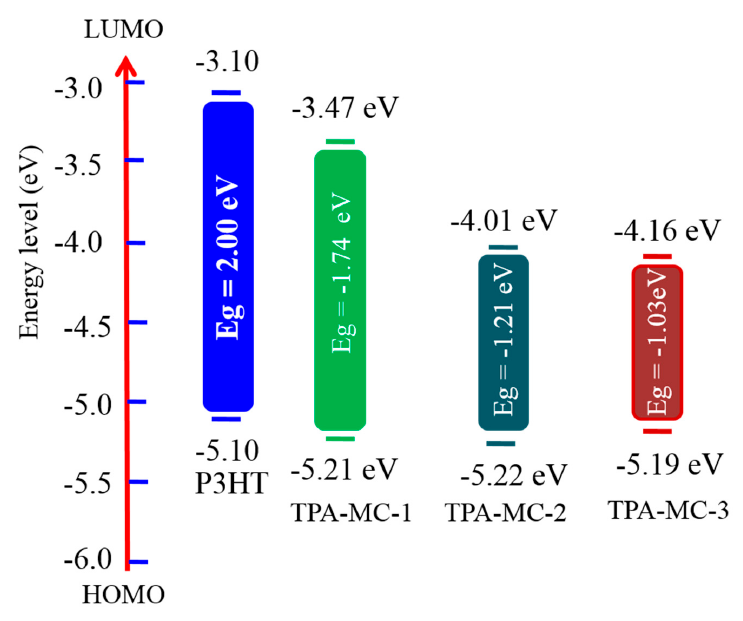
Figure 5. Energy band diagram of P3HT, TPA-MC-1, TPA-MC-2, and TPA-MC-3.